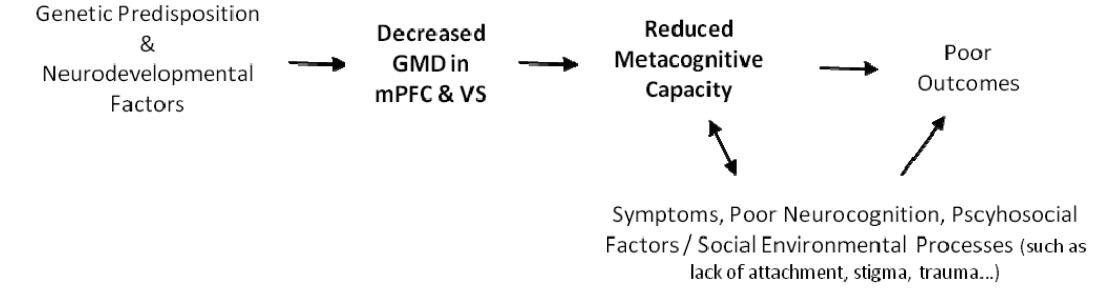
Figure 3. A path from gene to brain to dysfunctional behavior in